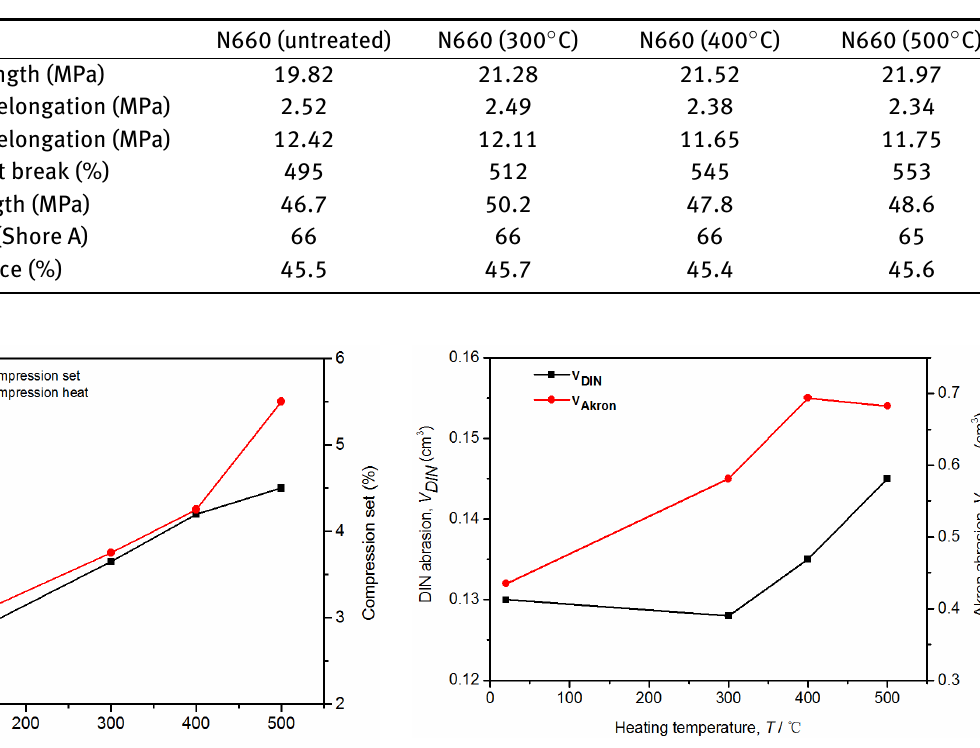
Figure 14: Effect of temperature on abradability of vulcanized rubber filled with